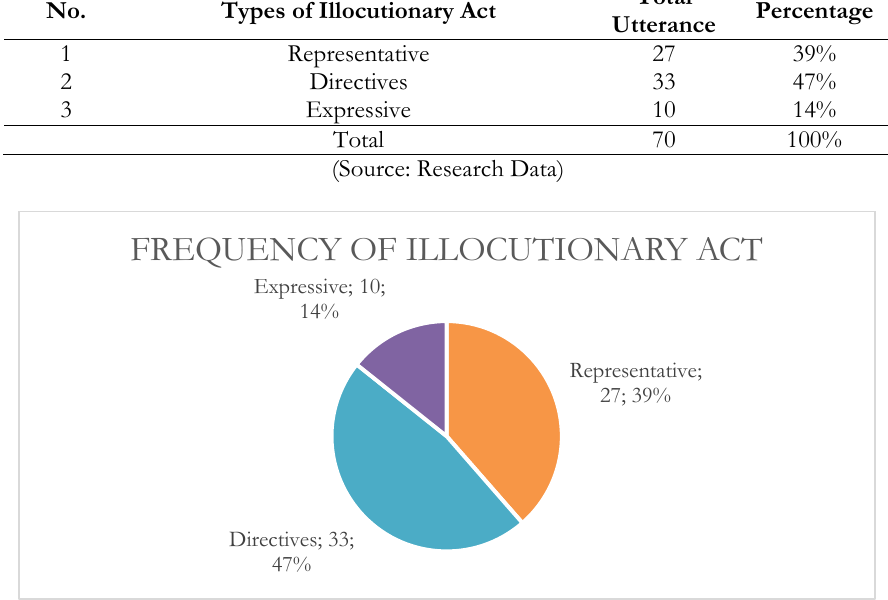
Figure 1. Frequency of Illocutionary